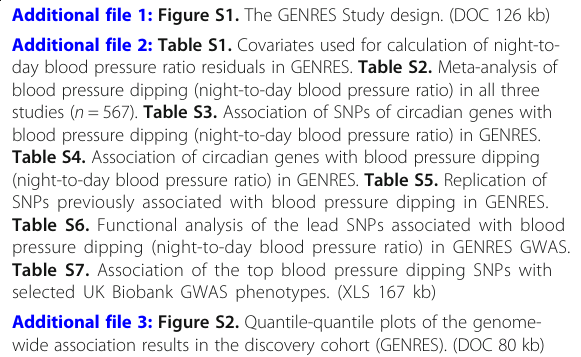
Table S6. Functional analysis of the lead SNPs associated with blood pressure dipping (night-to-day blood pressure ratio) in GENRES GWAS. Table S7. Association of the top blood pressure dipping SNPs with selected UK Biobank GWAS phenotypes. (XLS 167 kb) Additional file 3: Figure S2. Quantile-quantile plots of the genome- wide association results in the discovery cohort (GENRES). (DOC 80 kb)